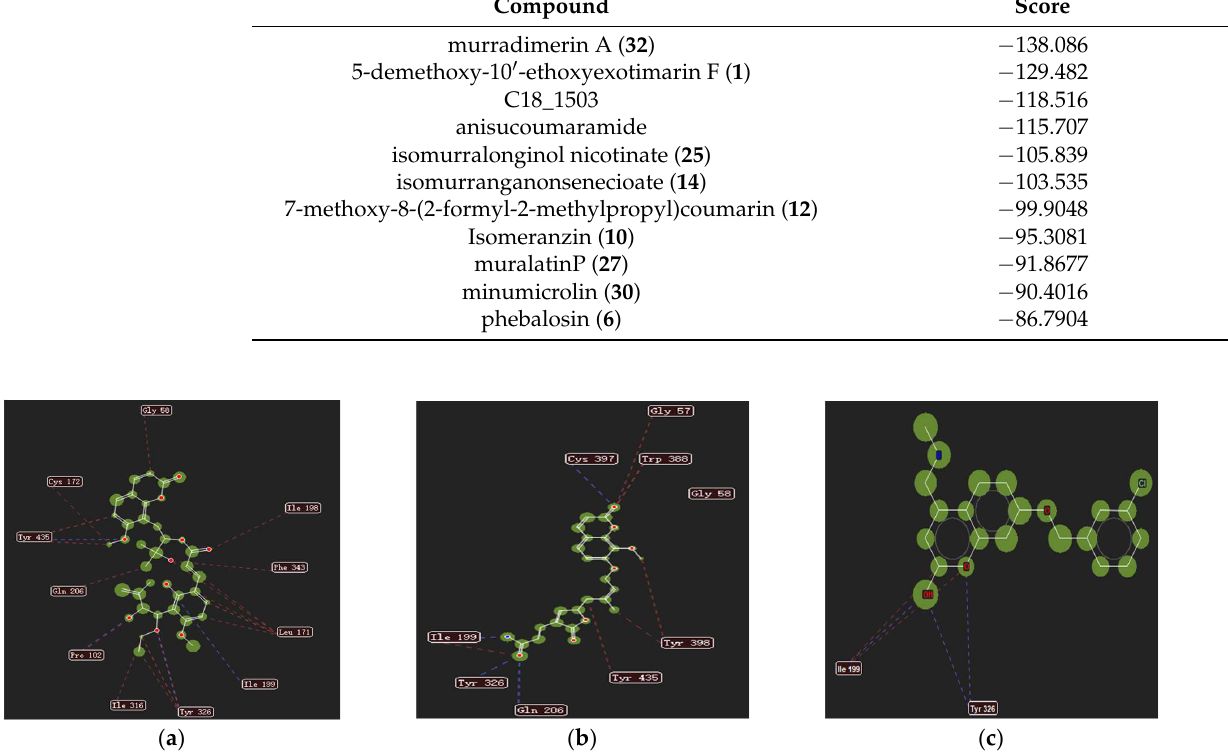
Figure 4. Protein crystals 2D interactions with ( 1 ), anisucoumaramide, and C18_1503. ( a ) 5-demethoxy-10′-ethoxyexotimarin F ( 1 ); ( b ) anisucoumaramide; ( c ) C18_1503.